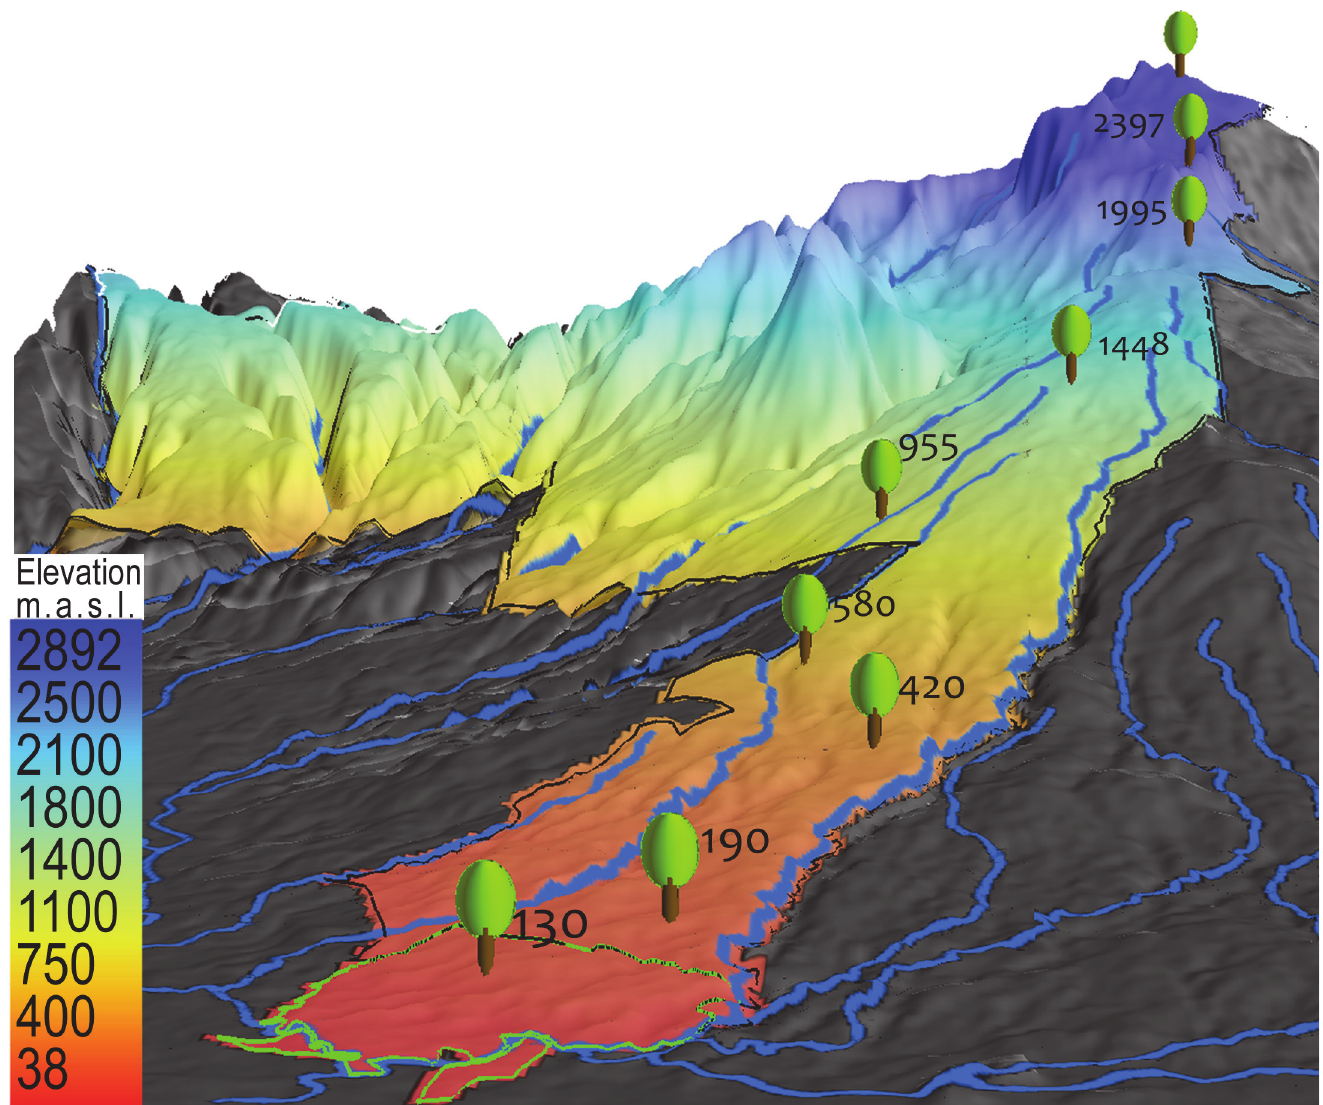
Fig 1. Plot locations. Location of the 9 1-ha forest inventory plots along the elevational gradient from 100 to 2800 masl on the eastern slopes of Volcán Barva, Costa